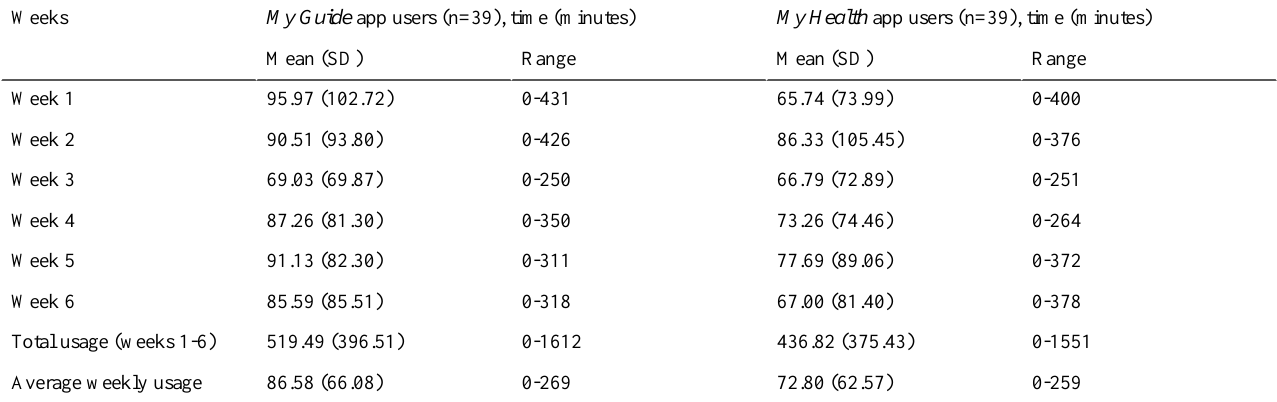
Table 2. Total time and average time of app